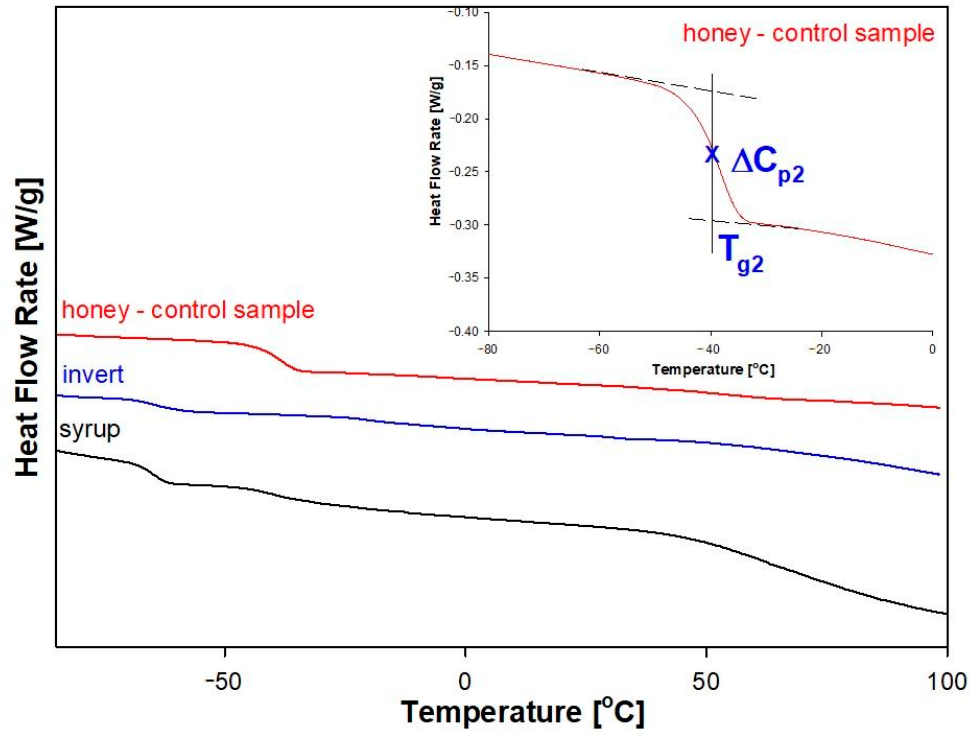
Figure 4. Comparison of heat flow rates of control honey sample (red), syrup (black) and invert (blue) versus temperature. The inset shows the enlargement of the glass transition region together with temperature of glass transition (T g ) which was determined at the half height of the jump of heat capacity ( Δ C p ) of the control honey sample.